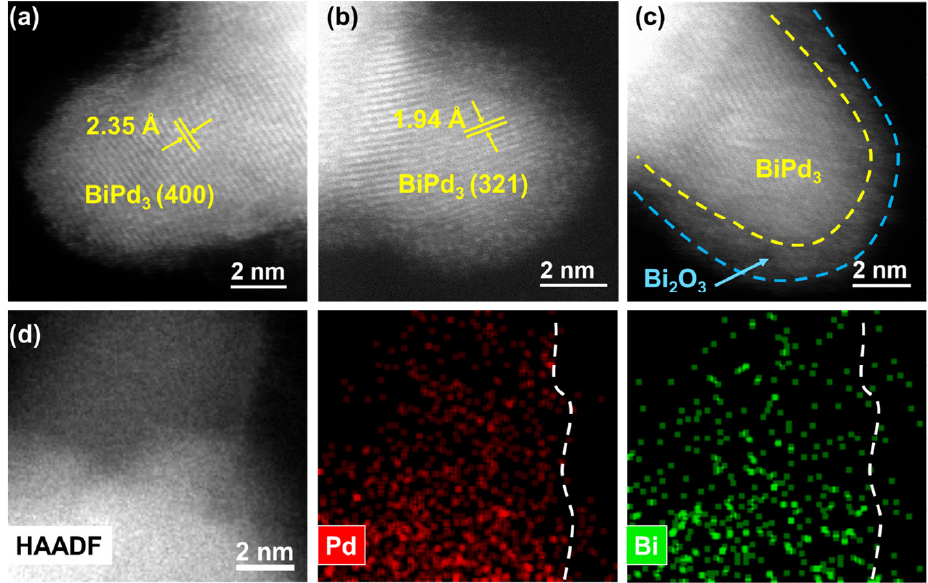
Figure 2. Microstructure of Pd NCs@Bi 0.5 . ( a – c ) HAADF-STEM images, ( d ) High-resolution HAADF image and elemental mapping analysis.